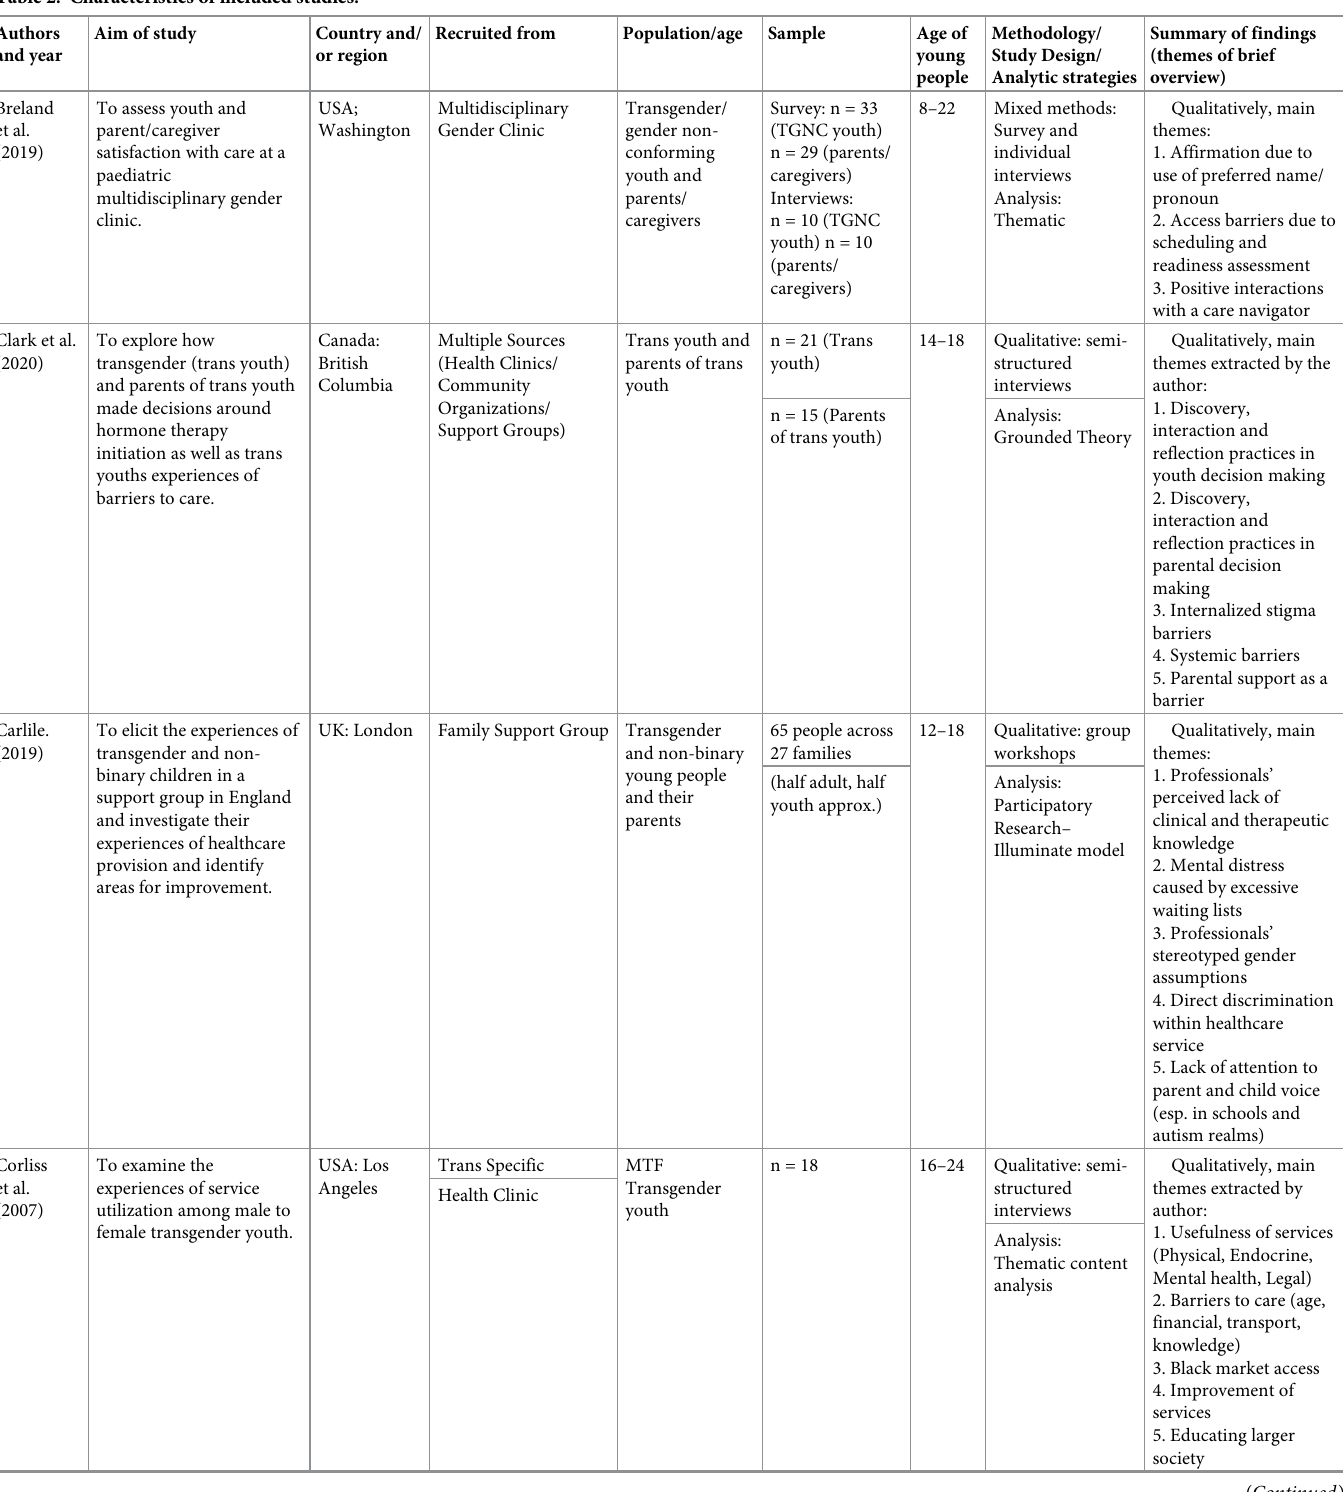
Table 2. Characteristics of included